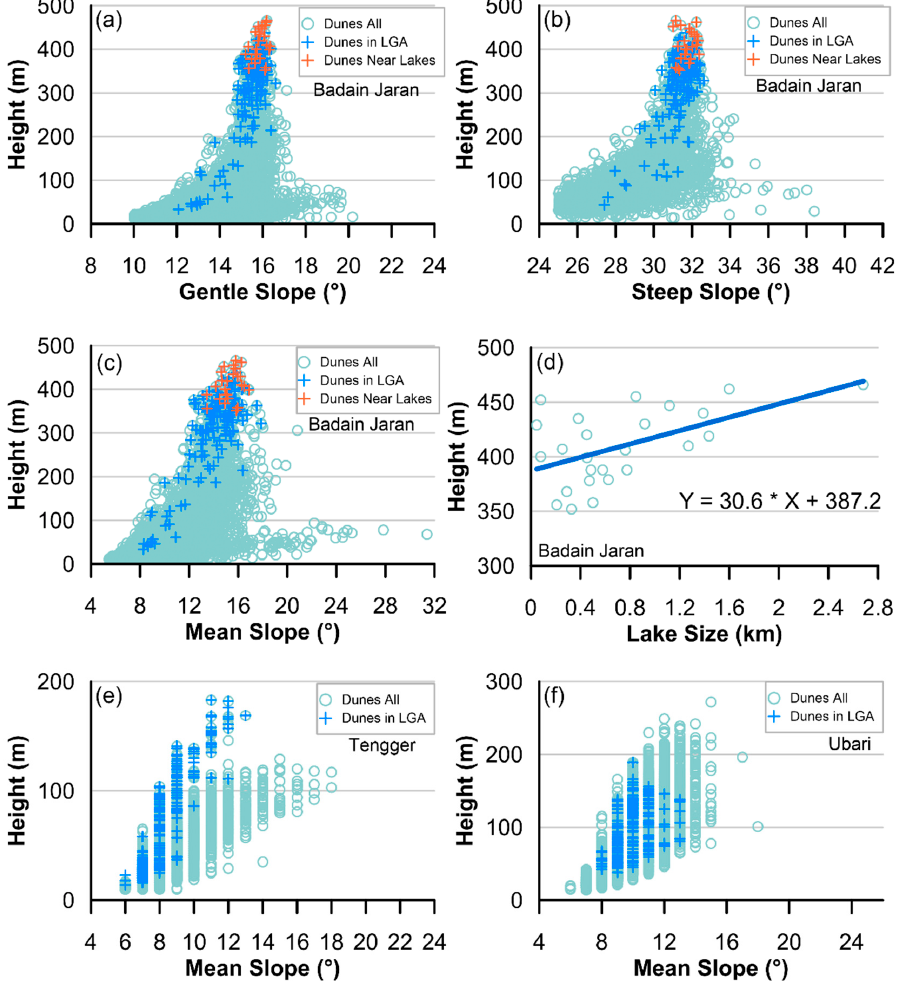
Figure 6. Scatter plots showing the relationship between the dune height and the ( a ) gentle (10°–25°), ( b ) steep (>25°), and ( c ) mean (>5°) dune slopes; ( d ) the lake size (considered to be the square root of the lake area) in the Badain Jaran Sand Sea; and the relationship between the dune height and the mean (>5°) dune slopes in ( e ) the Tengger Sand Sea and ( f ) the Idehan Ubari Sand Sea. Blue crosses represent dunes in the lake group area (LGA). Orange crosses represent the dunes mapped to lakes. The blue line in ( d ) represents the linear fitting.